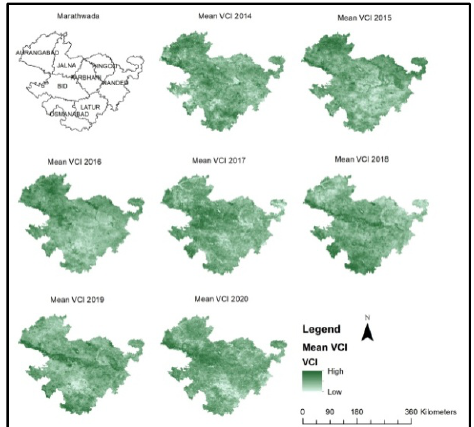
Figure 5: Annual mean VCI over Marathwada for 2014-2020 Districts of Parbhani, Latur and Nanded saw significant drop in annual average VCI for the years 2015 and 2016. The conditions improved in subsequent years. However new spots of low VCI starts to emerge in the districts of Beed and Latur in 2019 and 2020 showing the shift in pattern.